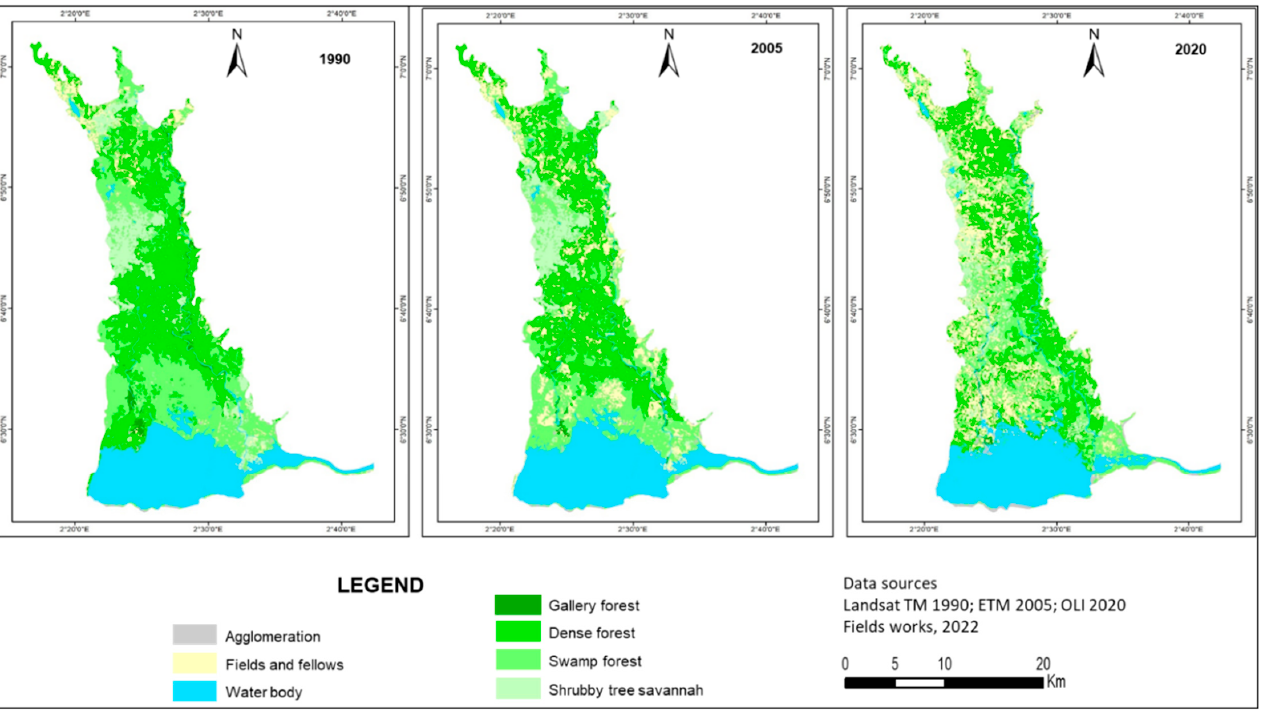
Figure 2. Maps of the evolution of the vegetation cover in the Ouémé Delta between 1990, 2005, and